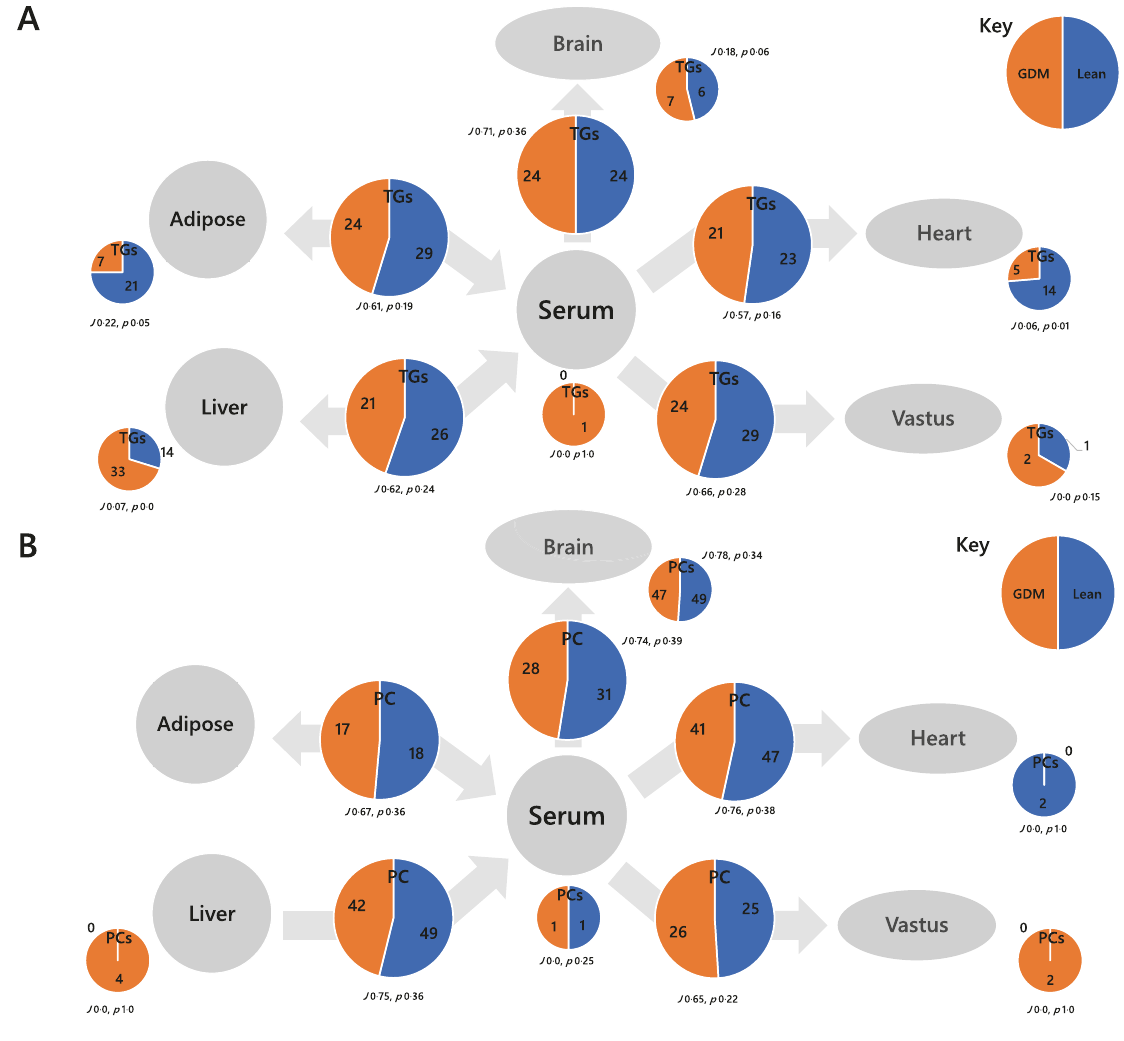
tissues. J represents the Jaccard-Tanimoto distance and p the accompanying probability that the binary list of variables for the two groups differed by random chance